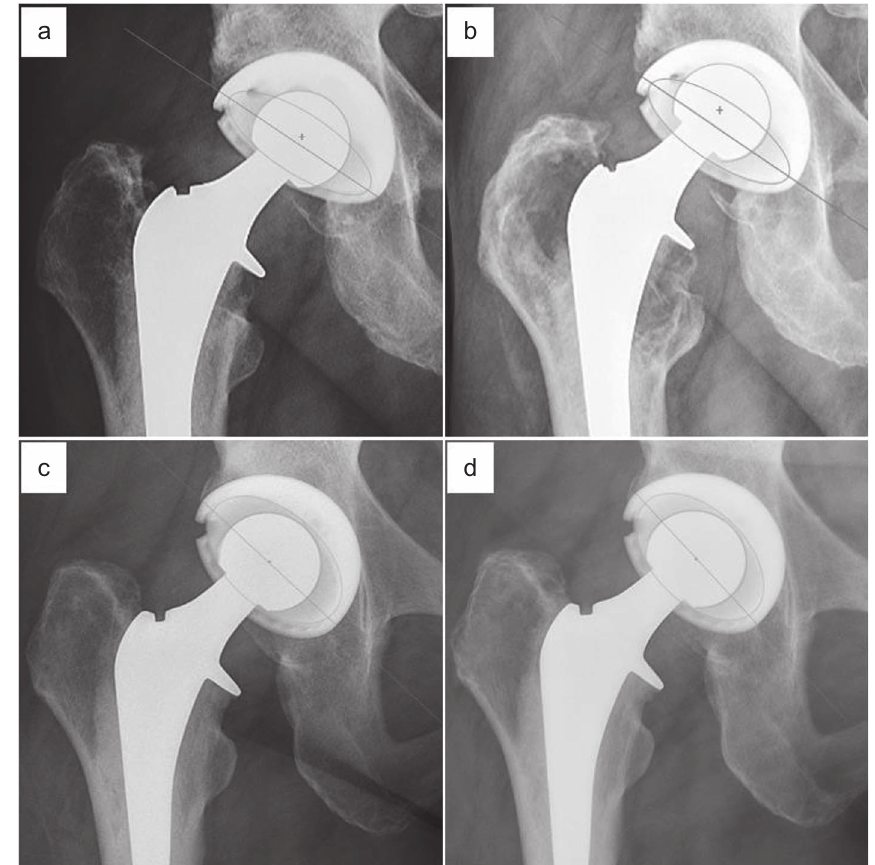
Figure 1. (a) Postoperative and (b) 11.31 year follow-up radiographs of a 28 mm cobalt chrome head on UHMWPE Re fl ection polyethylene liner. Linear penetration of the head was measured to be 5.581 mm, with observed femoral osteolysis in Gruen zones 1 and 7 (white arrowheads). (c) Postoperative and (d) 10.53 year follow-up radiographs of a 28 mm cobalt chrome head on XLPE Re fl ection polyethylene liner. Linear penetration of the head was measured to be 0.335 mm, with no observed osteolysis. UHMWPE: ultra-high molecular weight polyethylene, XLPE: highly cross-linked